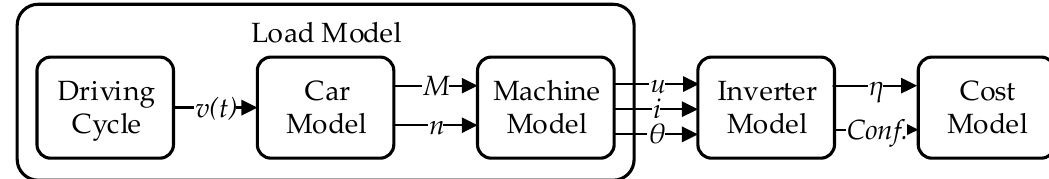
Figure 3. Block diagram of the simulation model indicating the sub-models and forwarded variables.